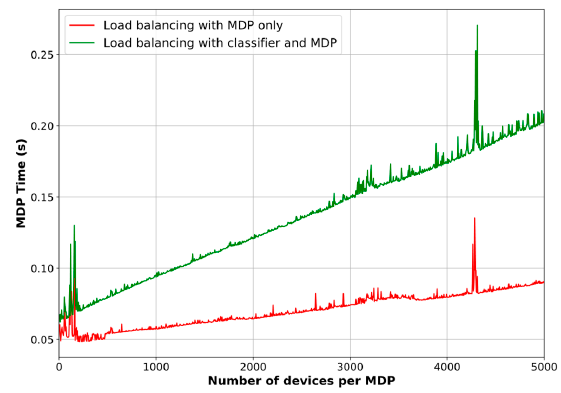
Figure 10. Computational time comparison for the MDPs.